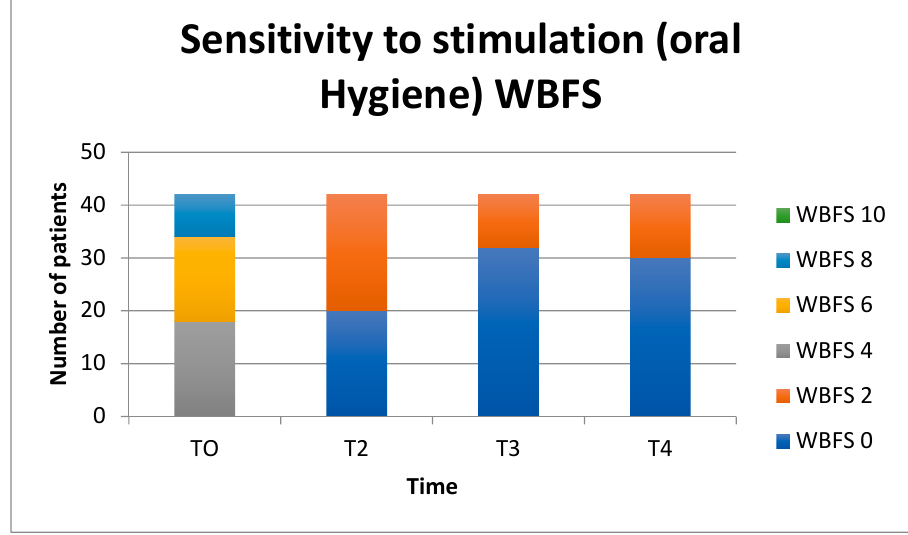
Figure 2. Wong–Baker faces scale (WBFS) sensitivity test to oral hygiene stimulation.